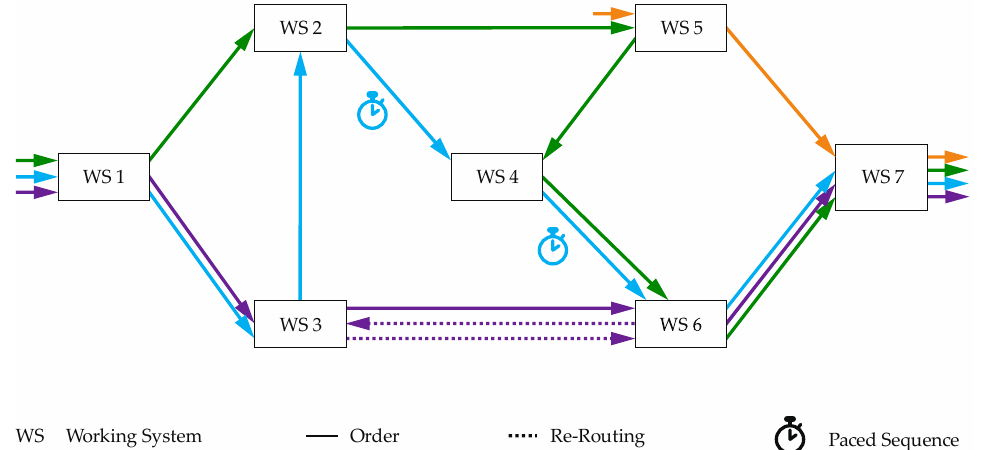
Figure 5. Structure of high-throughput systems for material testing [46].